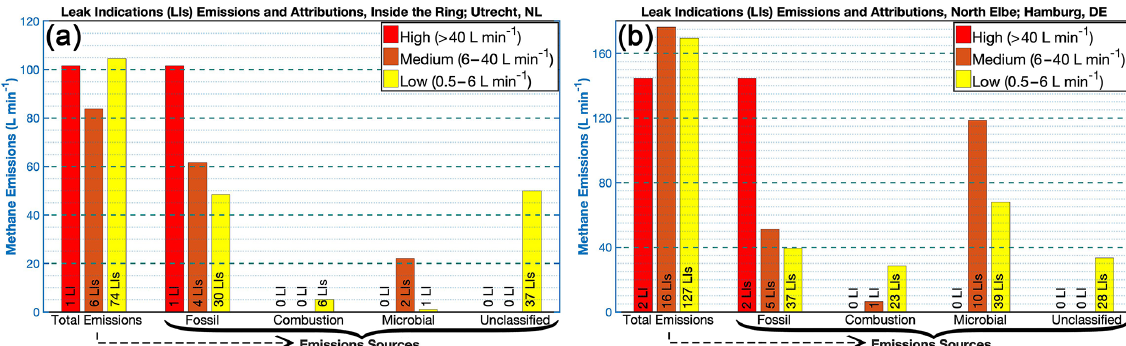
Figure 2. Total CH 4 emission rates from different sources in (a) Utrecht and (b) Hamburg; the arrow shows how the emissions are attributed to different sources.